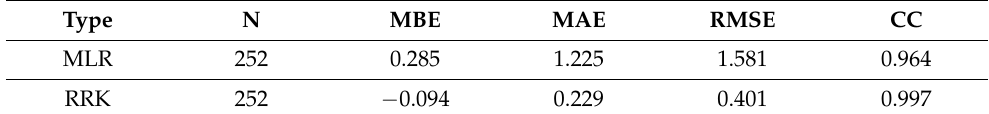
Table 8. Accuracy statistics of the MLR and RRK gap-filling using the GK2A SST images with the null pixel ratio less than 0.4 in the far seas (outside 30 km buffer).